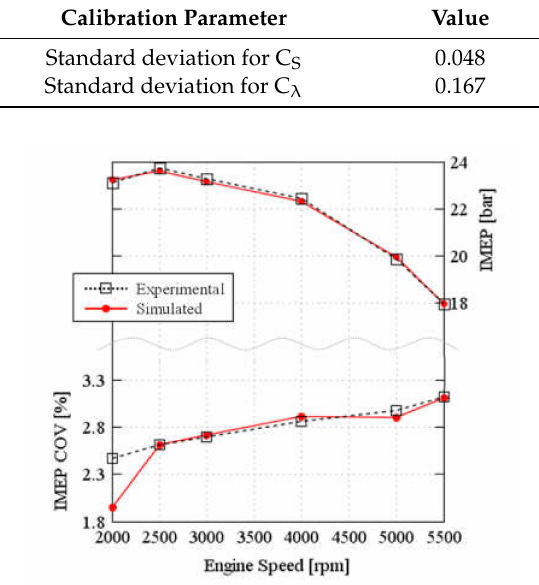
Figure 4. Coe ffi cient of Variation of the Indicated Mean E ff ective Pressure (top) and average Indicated Mean E ff ective Pressure over 300 CCV-cycles (bottom) at Full-Load without Port Water Injection PWI; simulated (red solid line) and experimental (black dashed